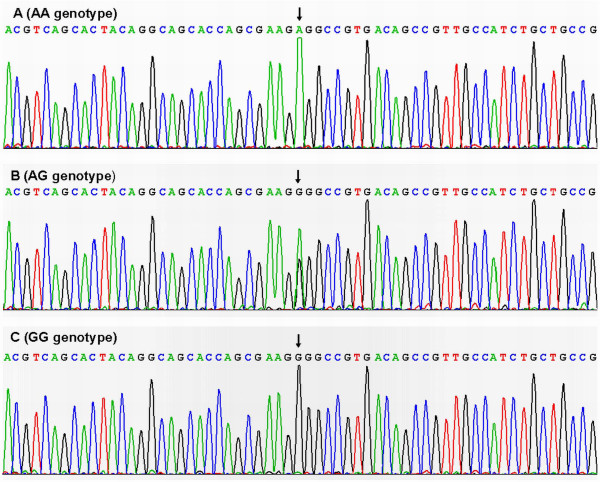
A part of the nucleotide sequence of the PCSK9 E670G polymorphism. (A) AA genotype; (B) AG genotype; (C) GG genotype.